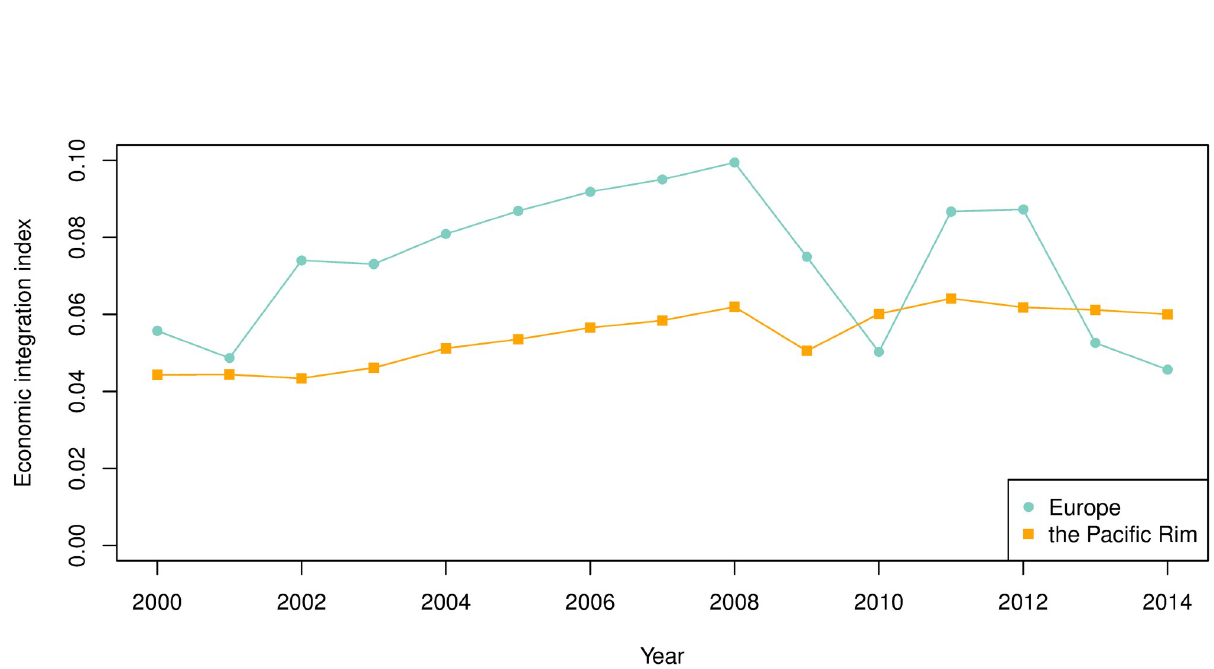
Fig 8. Economic integration estimation of the two regional communities in 2000–2014.